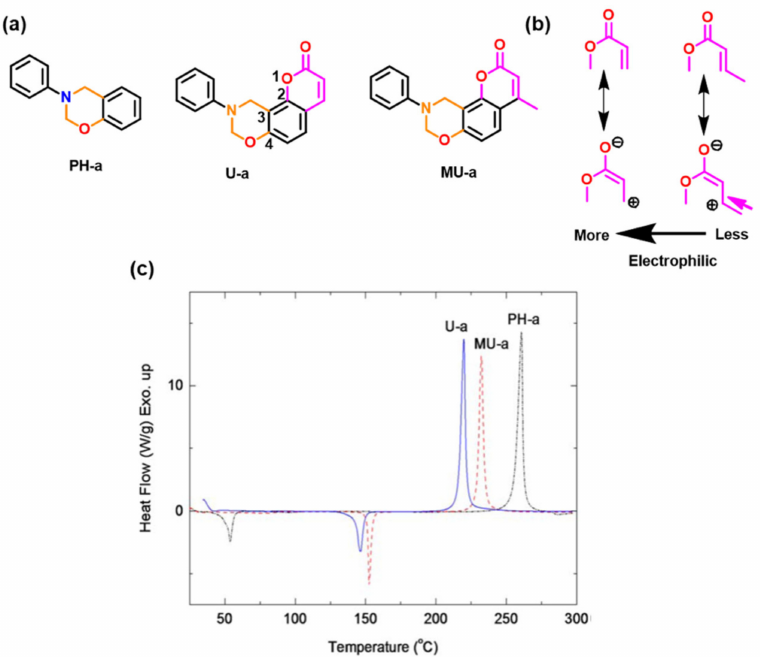
Figure 19. ( a ) Coumarin based monomers, ( b ) schematic depiction showing the resonance of a compound and the electronic implications, evidencing the origin of the activated electrophilic olefins, also referred to as Michael acceptors, and ( c ) DSC thermograms of the benzoxazine monomers [210]. Copyright 2015. Reproduced with permission from 2015 Wiley Periodicals,